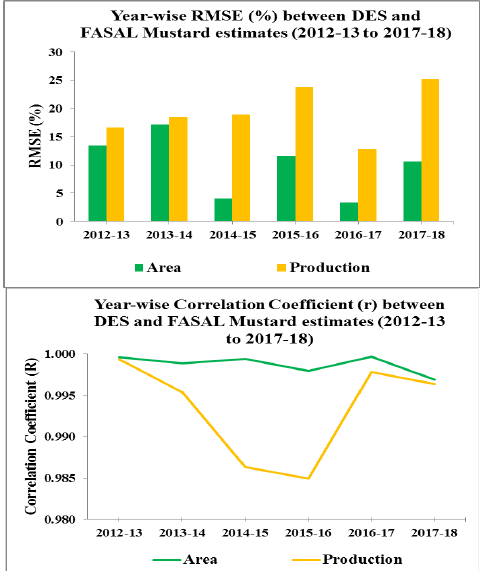
Figure 11: State-level year-wise comparison between DES and